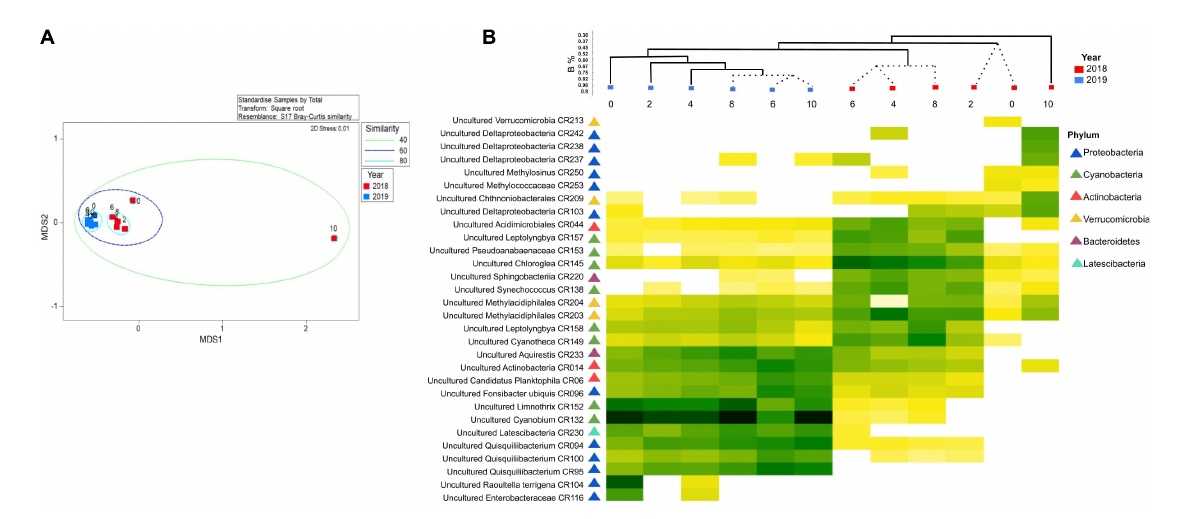
FIGURE3 (A) Non-metric multidimensional scaling (NMDS) of bacterial community structure for the Lake Cote. Similarity circles were based on Bray-Curtis coefficient. (B) Shade-plot of standardized, square root-transformed abundance of 30 ASVs, selected by index of association. Samples were arranged according to LINKTREE results, where dotted lines indicate no significant relation between the samples. Dendrogram using Bray-Curtis similarity coefficient showing the similarity among the samples.